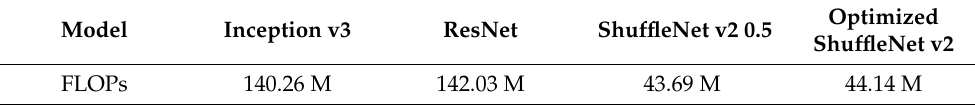
Table 5. FLOPs of different models.